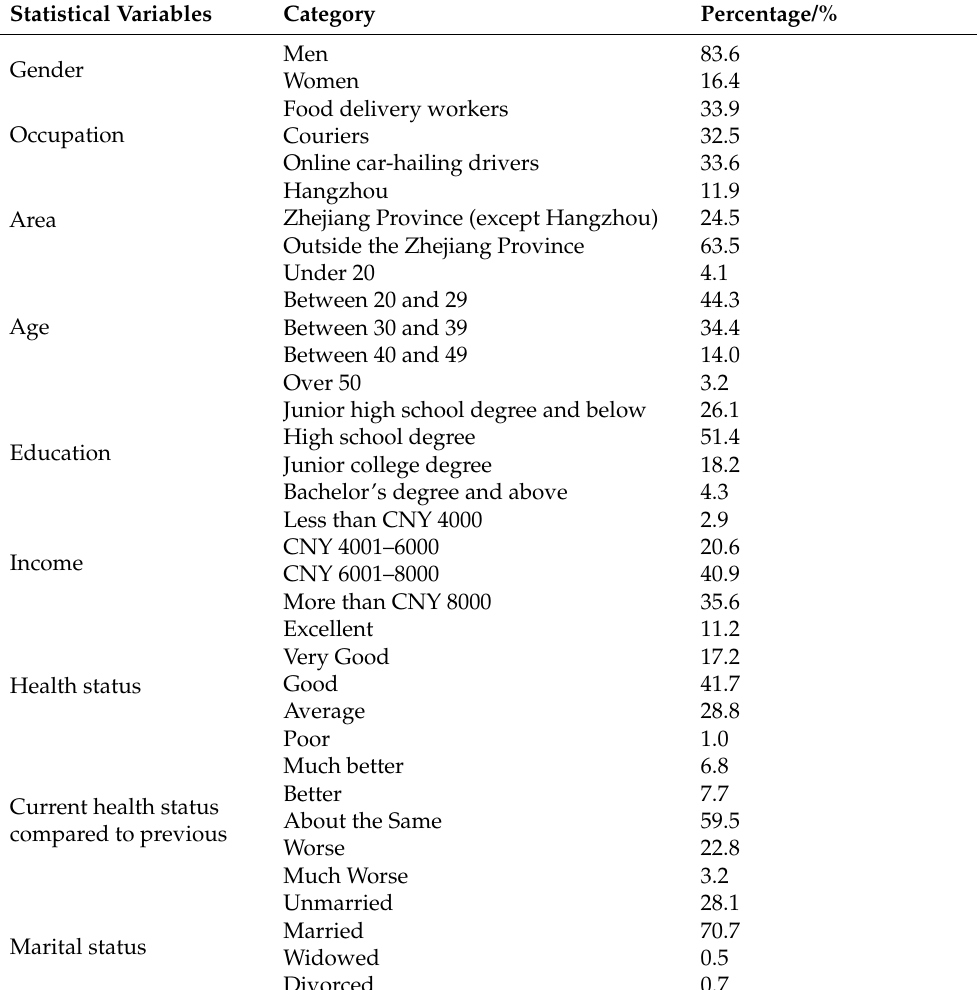
Table 3. Frequency of Basic Information of